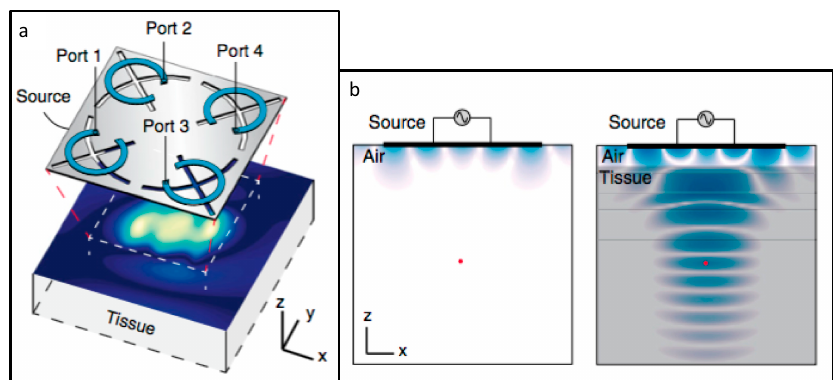
Figure 3. ( a ) Schematic of the 1.6 GHz midfield power source placed above tissue and the magnetic field on the skin surface; and ( b ) the resulting magnetic field in air and couple into tissue. Reproduced with permission from [12].